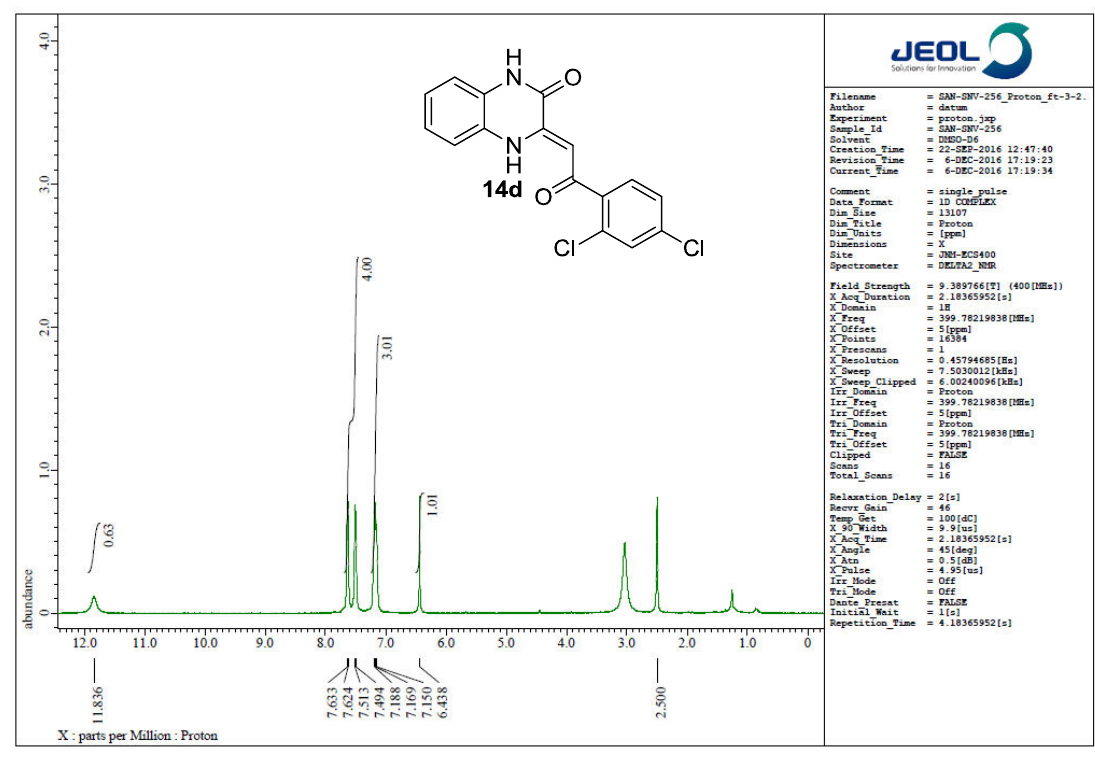
Figure 35 . 1 H NMR Spectra of Compound 14d .